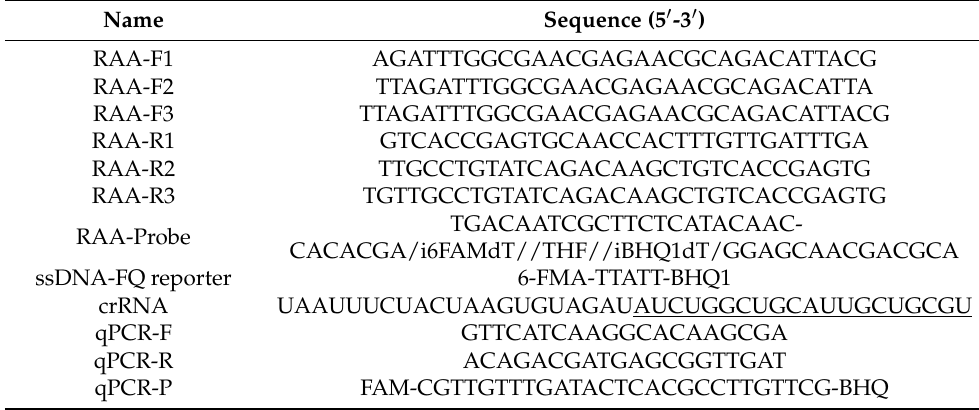
Table 2. Primers and probe used in this